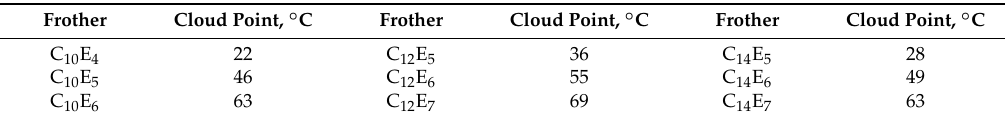
Cloud point of selected frothers in 0.1 weight fraction aqueous solutions present in the polyoxyethylene-type non-ionic frother/water sub-system of frother aqueous solutions system (based on [30]). Frother Cloud Point, ◦ C Cloud Point, ◦